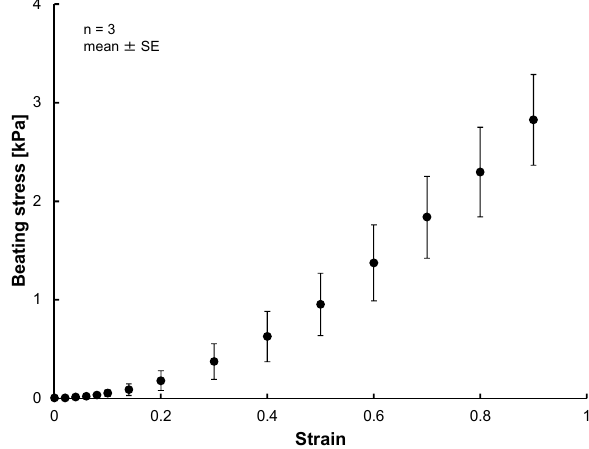
Figure 9. Strain-beating force properties of the cardiac 3D tissues. The beating forces were increased with the increment of strain.